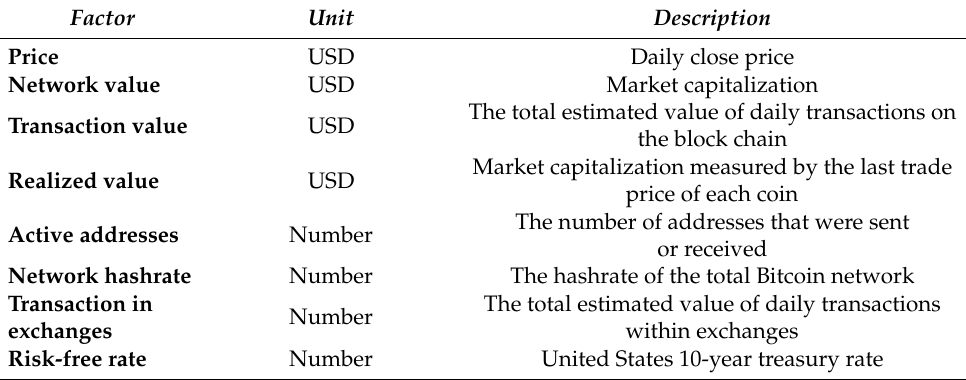
Table 2. Description of the variables used in the empirical